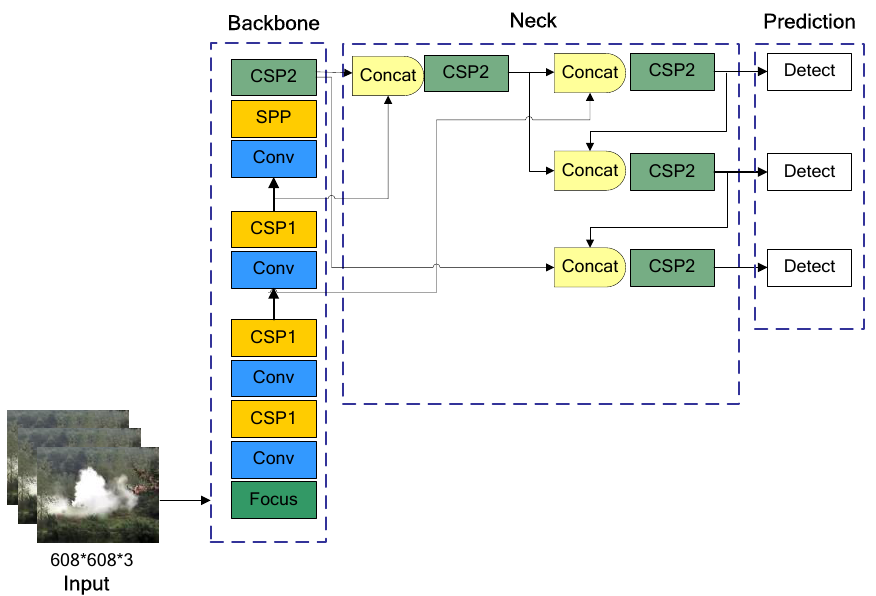
Figure 1. YOLOv5 network structure.